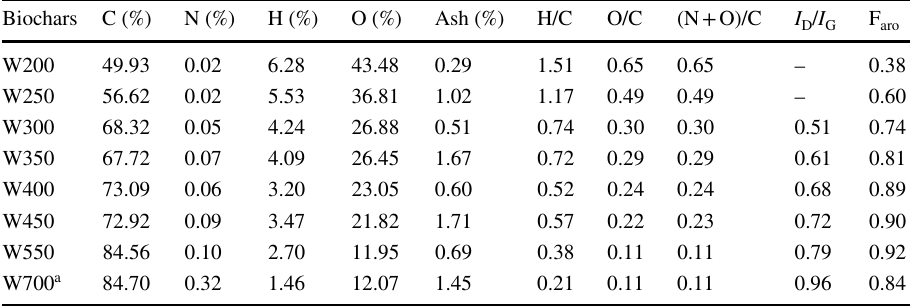
chemical properties of